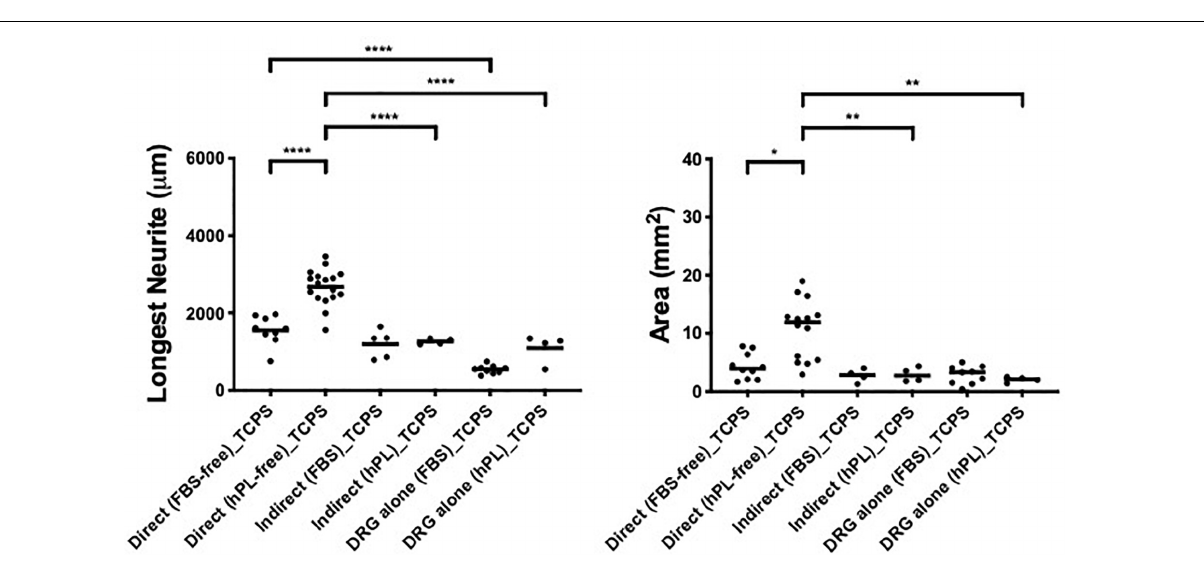
FIGURE 7 | Influence of tissue culture plastic (TCPS) on DRG outgrowth. Longest neurite and axonal area of direct co-culture, indirect co-culture, and DRG alone on TCPS. Three biological repeats and at least three technical replicates (DRG) were assessed. One-way ANOVA with Tukey’s multiple comparison tests was used for assessing statistical significance among the examined groups (* p < 0.05, ** p < 0.01, *** p < 0.001, **** p < 0.0001). The number of DRG tested corresponds to the number of dots for each condition in the